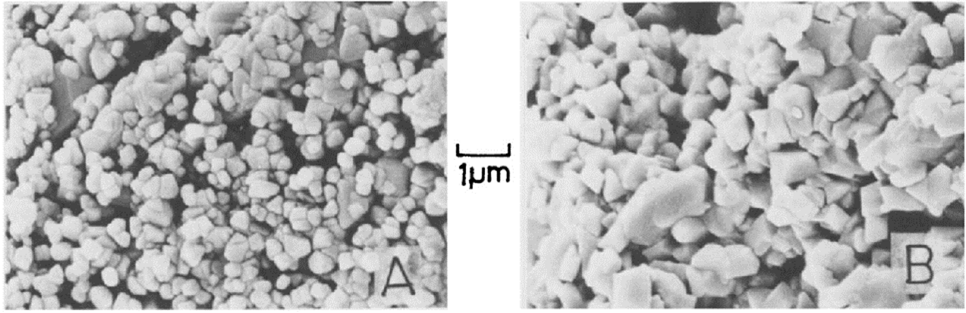
Figure 4. SEM images of porous ceramics: ( A ) MgCr 2 O 4 ; ( B ) 7MgCr 2 O 4 ·3TiO 2 . Reprinted with permission from [83]. Copyright 1980, The American Ceramic Society.